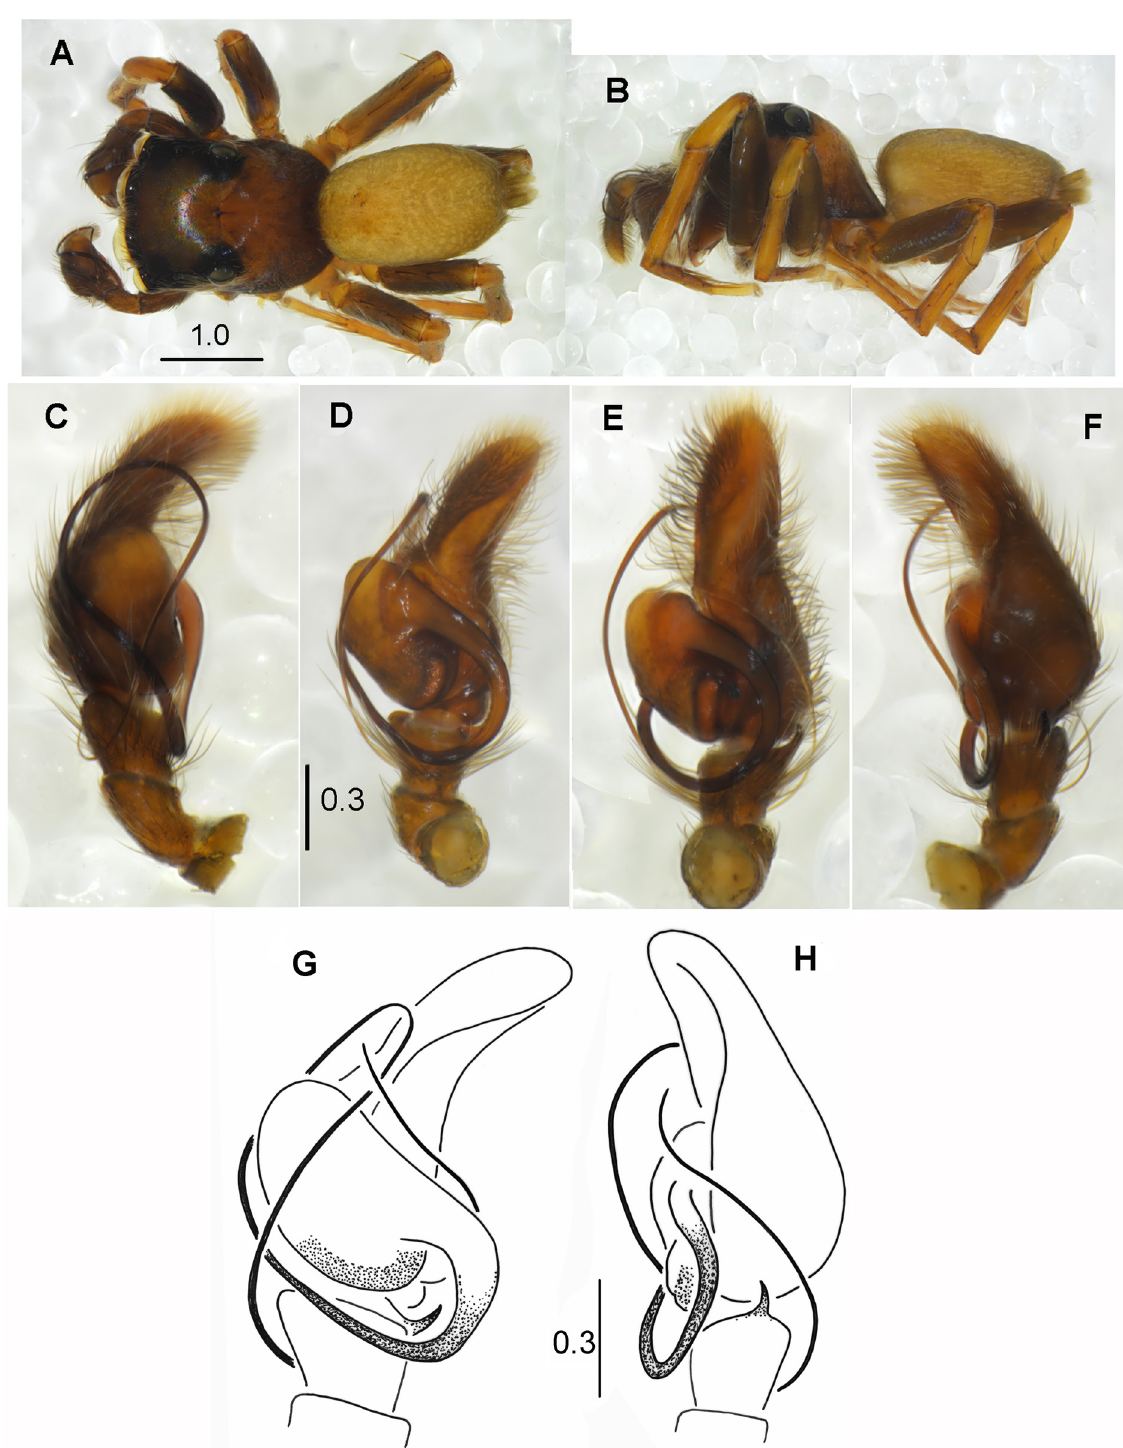
Fig. 4. Ansienulina lamottei sp. nov., holotype, ♂ (MNHN). A . Habitus, dorsal view. B . Habitus, lateral view. C . Palpal organ, prolateral view. D, G . Palpal organ, ventral view. E . Palpal organ, ventrolateral view. F, H . Palpal organ, retrolateral